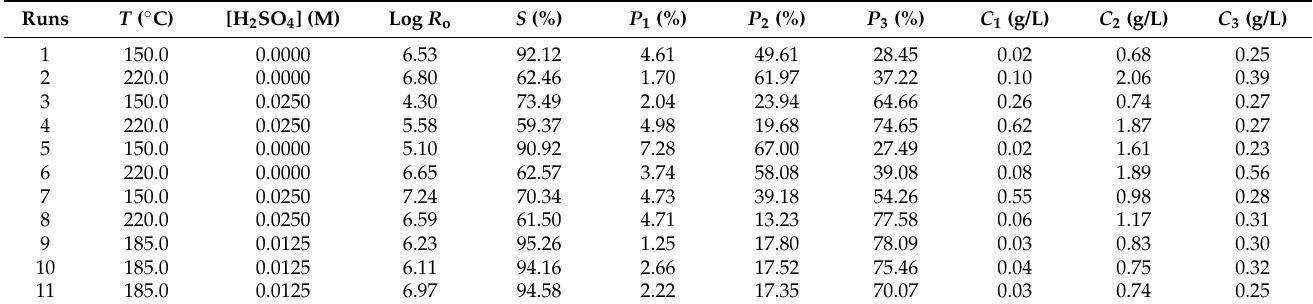
Table 3. Full factorial design matrix in the optimisation of thermochemical pretreatment conditions for old cellulosic fibers. Experimental responses ( S , P 1 , P 2 , P 3 , C 1 , C 2 , C 3 ) and Log R o